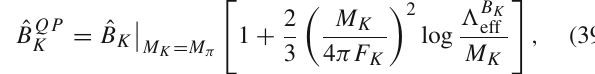
Fig. 5 Latticeresultsfor ˆ B K ,definedinEq.(37),inthecaseof N f = 0 (see Refs. [6,7]), and N f = 4 (this work). Error bars are only statistical errors. We also include the predictions from Ref. [20], where the band indicates the values obtained when varying the involved matching scale M from 600 to 1000